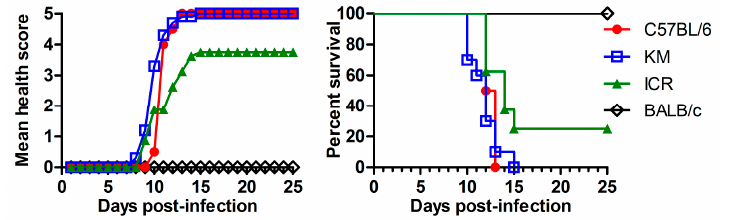
Figure 1. Susceptibilities of different species of neonatal mice to Zika virus (ZIKV) infection. ZIKV (PRVABC59) was used to infect the 1-day-old mouse i.p. (intraperitoneally) at a dose of 10 6 50% tissue culture infectious dose (TCID 50 )/mouse in 100 µ L volume. Mouse strains were as indicated: BALB/c, C57BL/6, Kunming (KM), and ICR (institute of cancer research). Each group contains 8–10 mice. ( Left ) Health score curve: mice were observed daily for body weight and clinical signs for 25 days after infection or until death. The grade of clinical signs was scored as following: 0, healthy; 1, lethargy and inactivity; 2, wasting; 3, limb weakness; 4, hind-limb or fore-limb paralysis and tremors; and 5, moribund and death; ( Right ) Survival rate curve: the mice were observed for 25 days after infection or until death, and the numbers of deaths and survivors were recorded on a daily base.